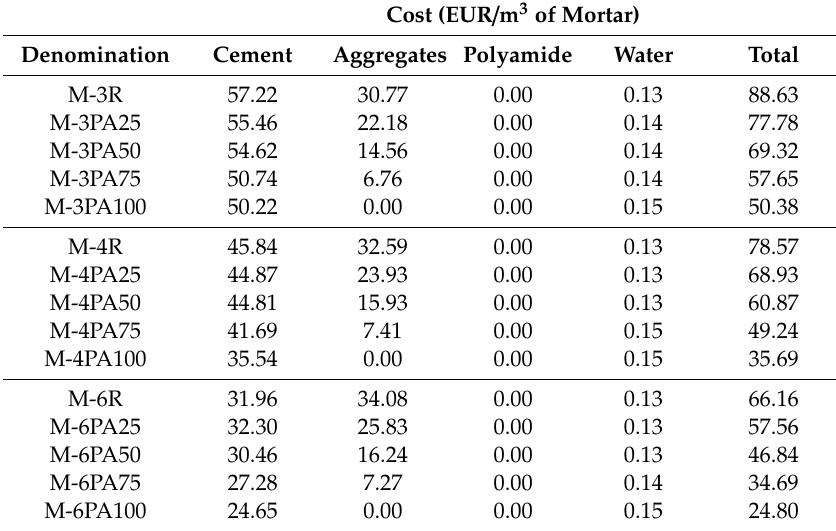
Table 13. Cost for each of the mortar denominations with a zero value for polyamide powder